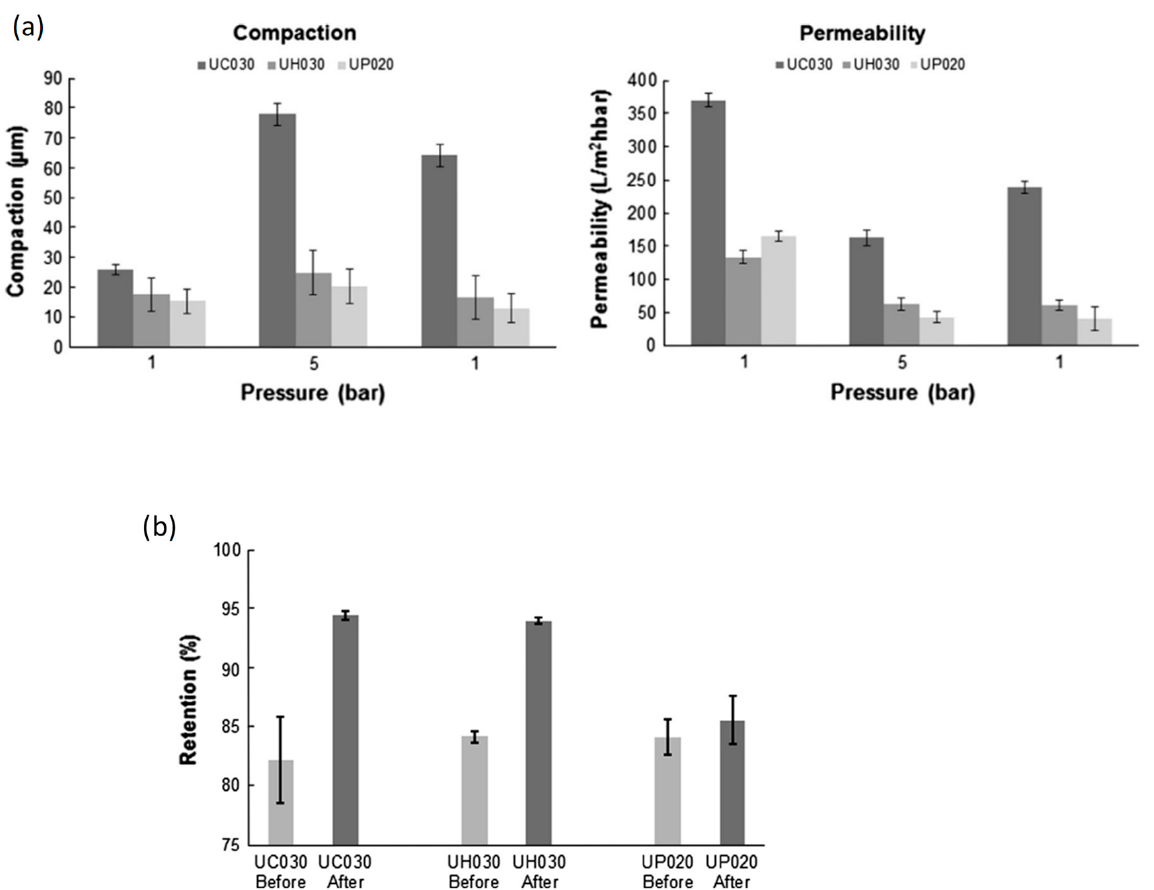
Figure 5. ( a ) Compaction and permeability of UC030, UH030, and UP020 membranes when com- pacted for 2.5 h at 5 bar; ( b ) effect of compaction (15 h at 7 bar, 30 °C) on the membrane retention of pacted for 2.5 h at 5 bar; ( b ) effect of compaction (15 h at 7 bar, 30 ◦ C) on the membrane retention 8 kDa polyethylene glycol (UH030 and UC030 membranes) and 6 kDa polyethylene glycol (UP020 membrane). Retentions were measured at a flux of 100 Lm − 2 h − 1 , and the average results from three different membrane sheets are shown. Reprinted with permission from Ref. [15]. Copyright 2013